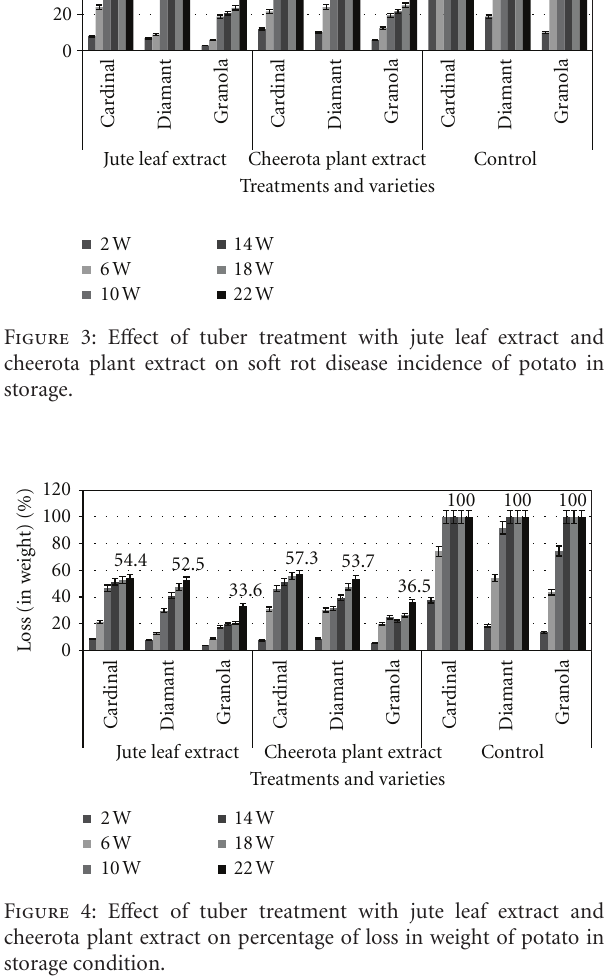
rot bacteria; ∗ : plant extract was not added in